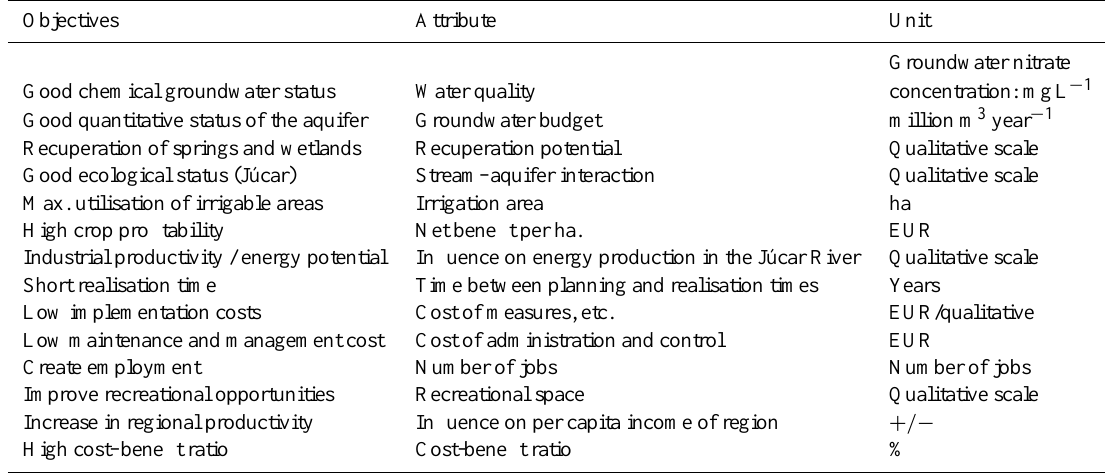
Table 2. Attributes and measurement units for the lowest-level